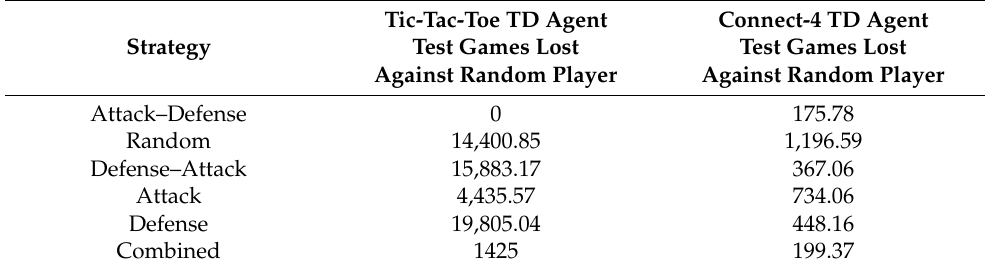
Table 3. Number of test games lost by the TD agent against a random player.